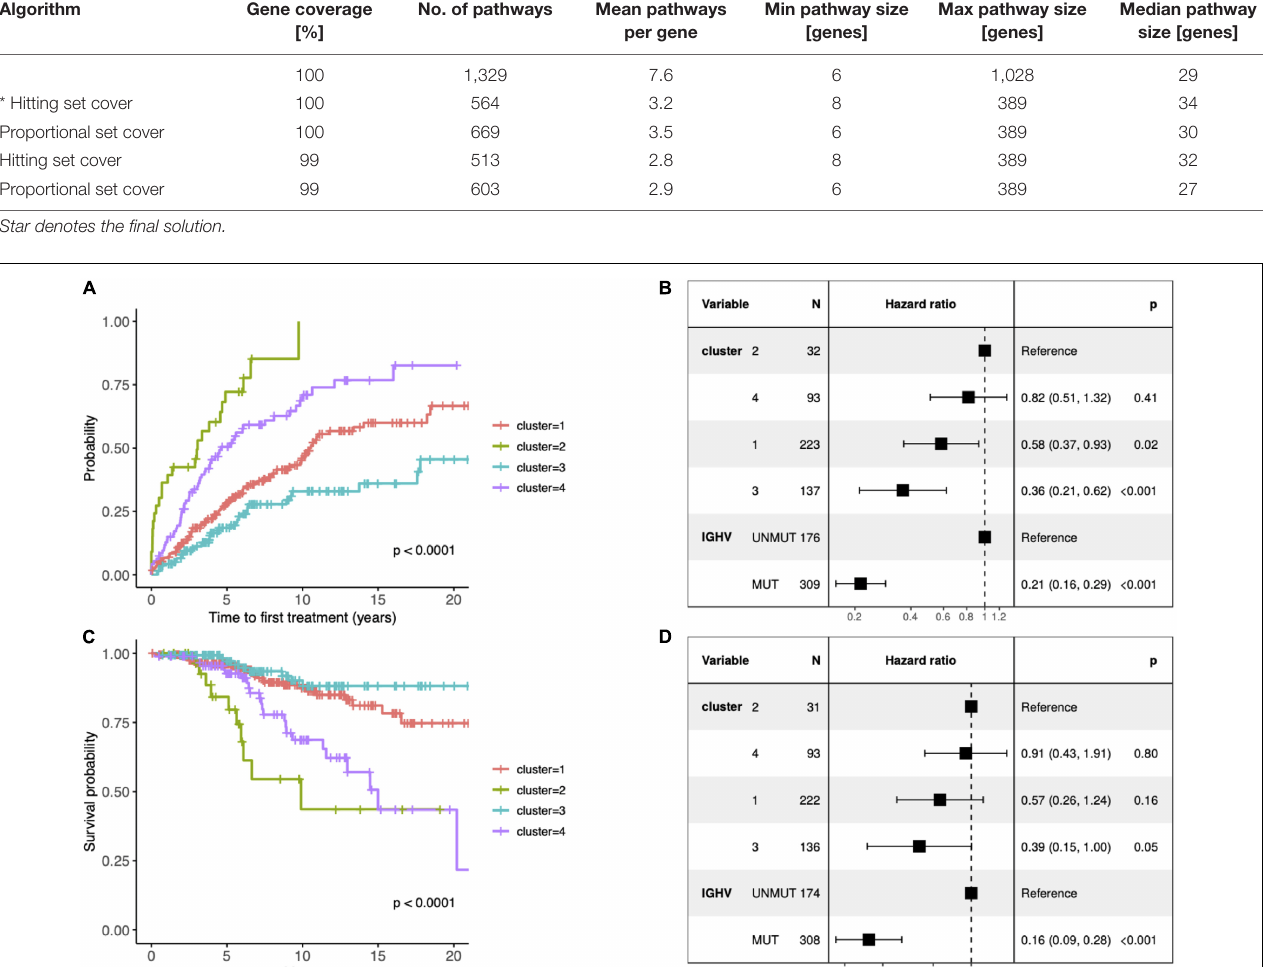
TABLE 1 | Reducing redundancy using two different set theory algorithms (hitting set cover and proportional set cover) with 100 and 99% gene coverage. The original canonical pathway signatures dataset is described in the first row.